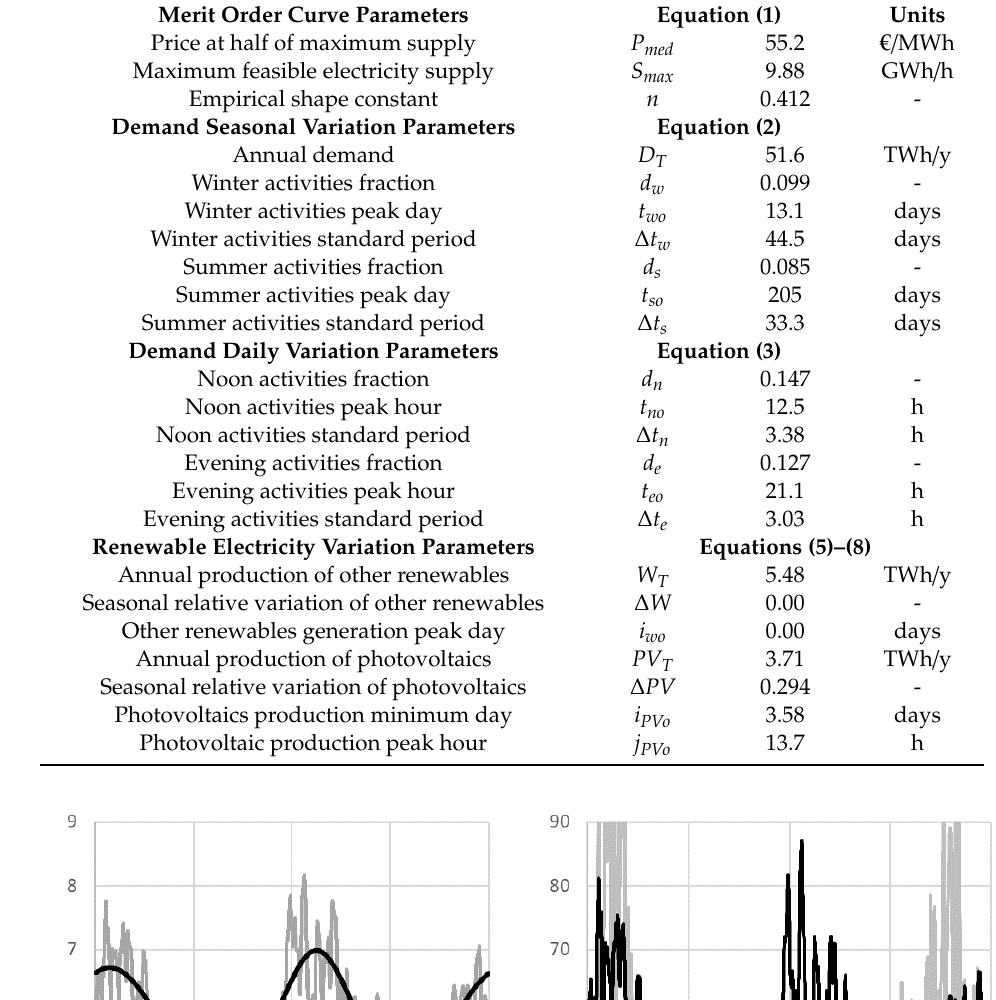
Table 2. Model parameter estimation results.